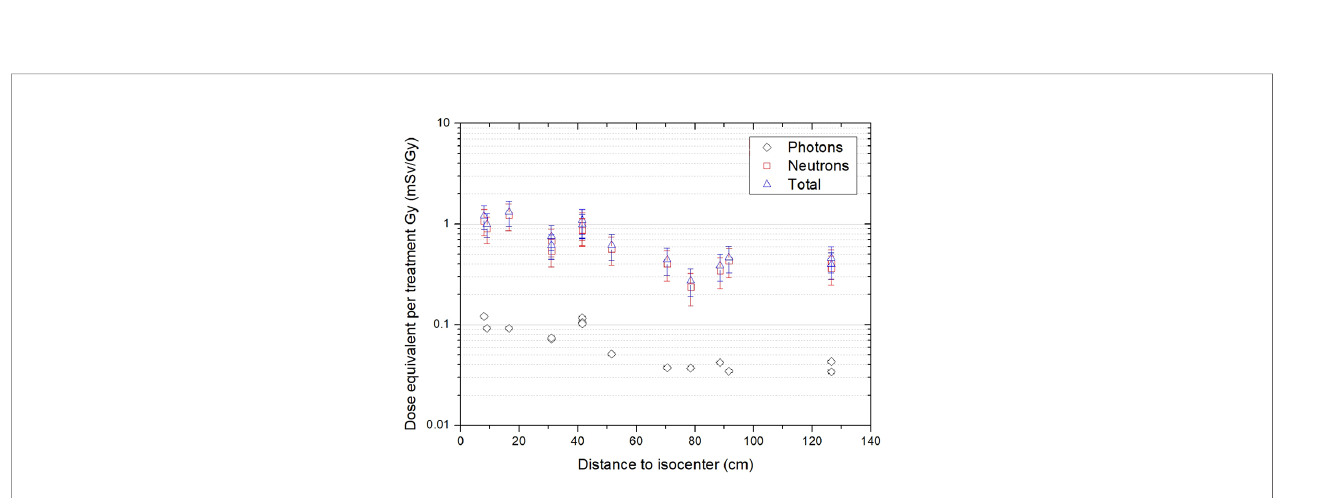
FIGURE 6 | Photon, neutron, and total dose equivalent per treatment Gy as a function of the distance to the